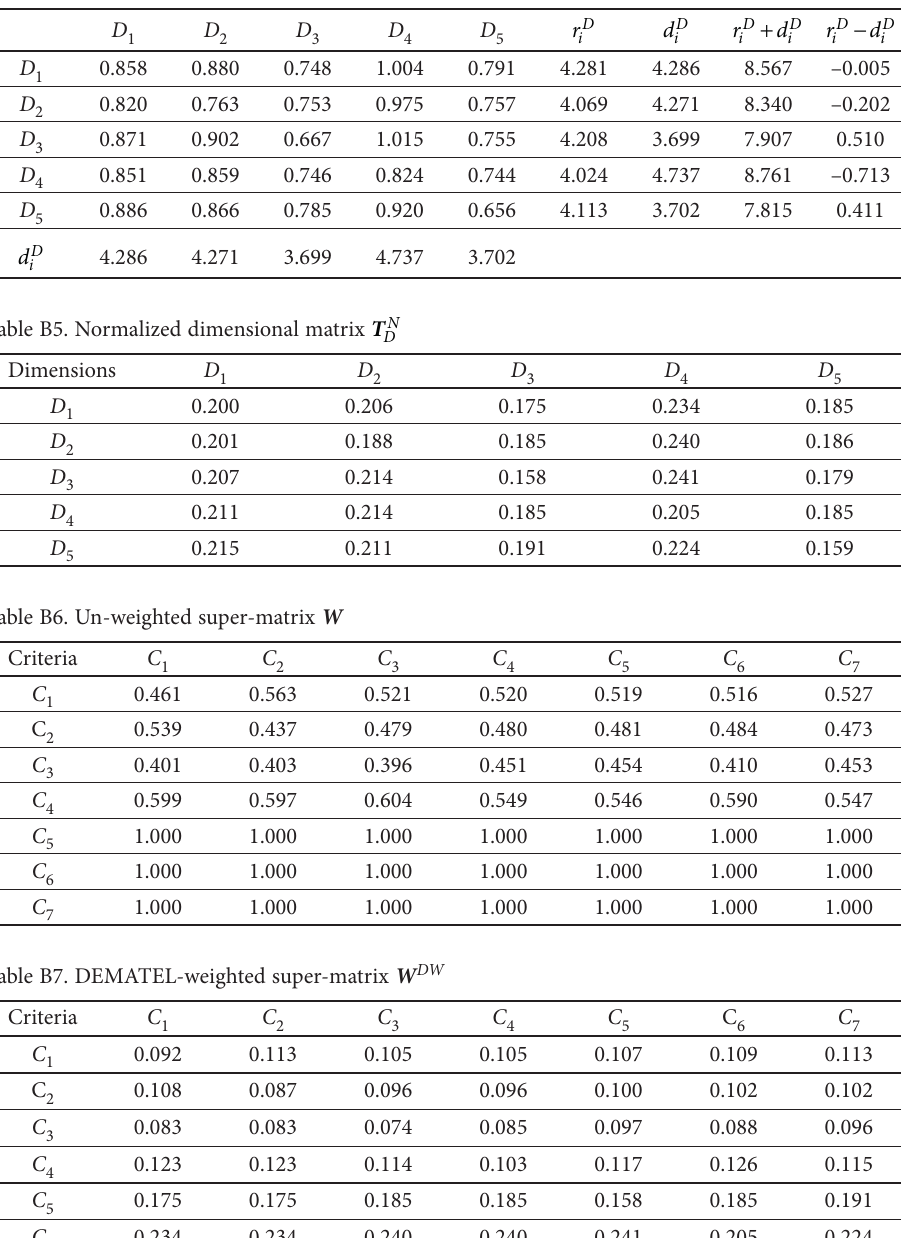
Table B4. Dimension matrix T